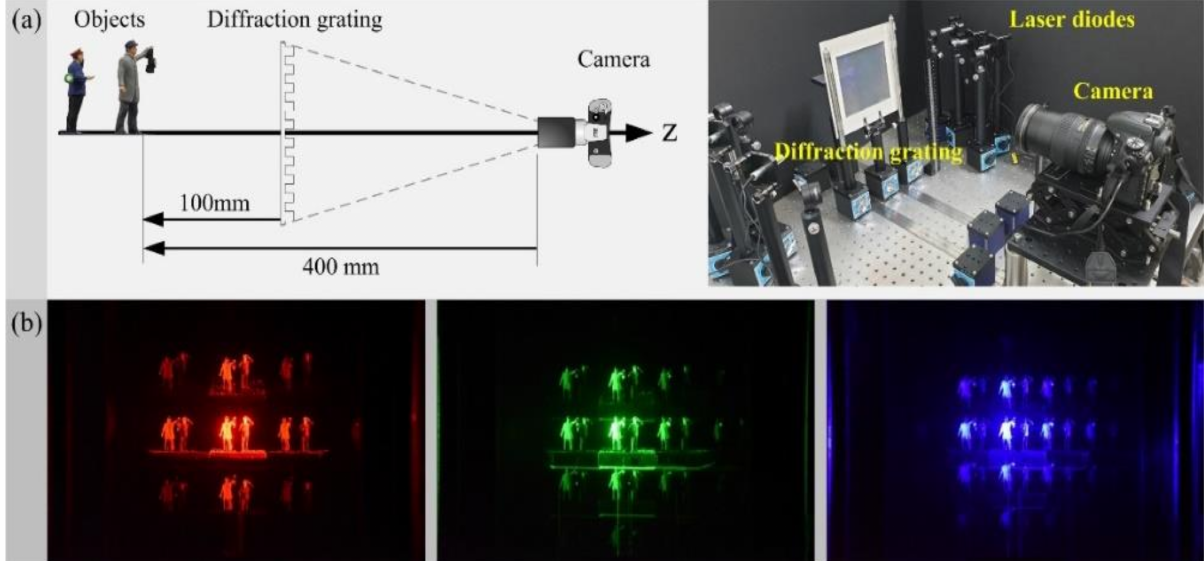
Figure 8. Experimental setup for PIA pickup. ( a ) Configuration of the optical experiment. ( b ) Examples of PIAs obtained from using lasers of wavelengths of 635 nm (red), 532 nm (green), and 450 nm (blue). See the text for the details on the configuration of optical